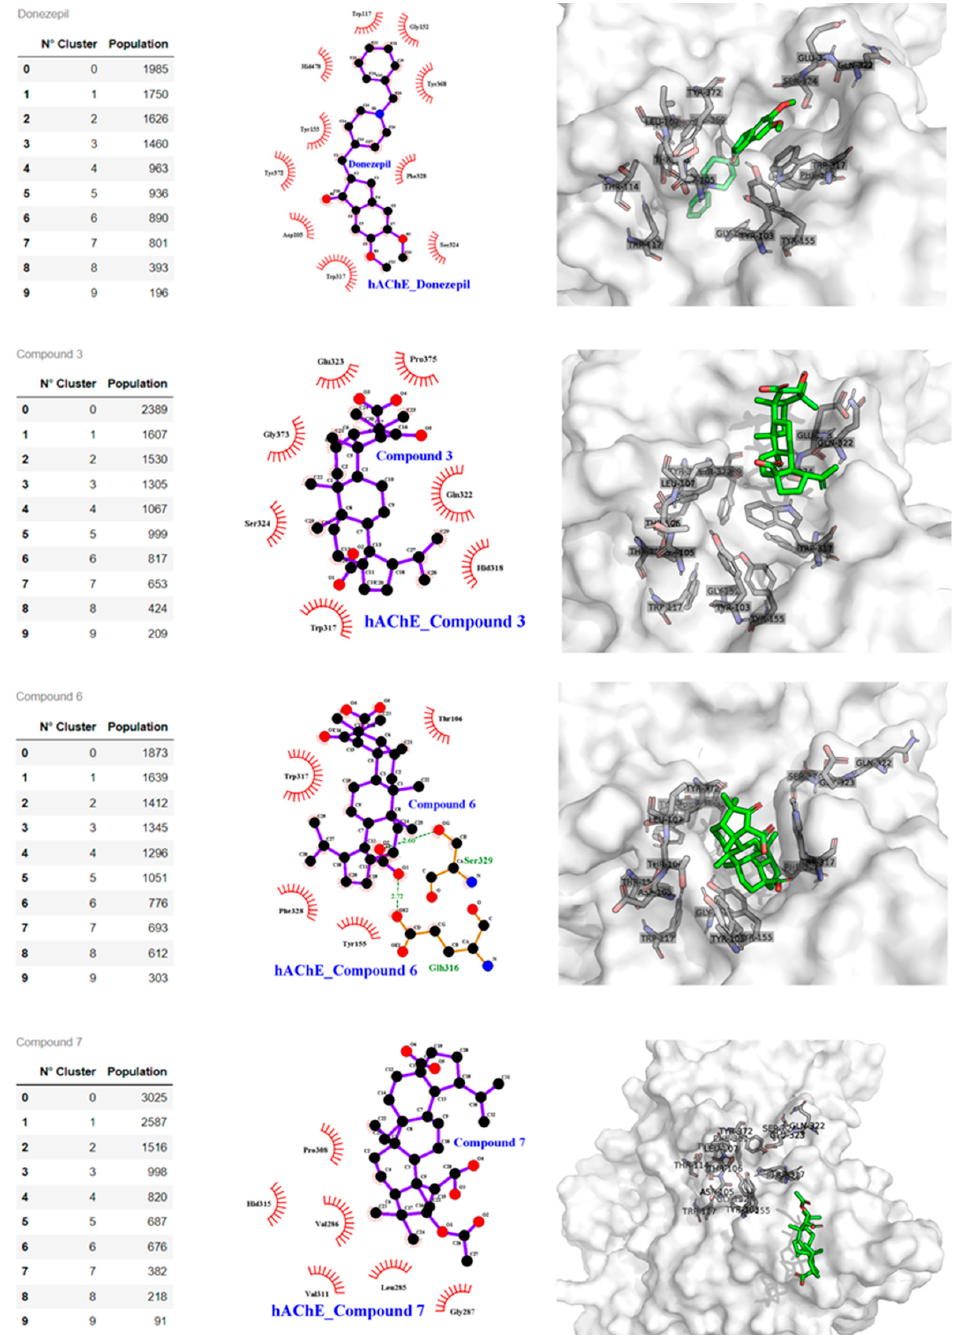
Figure 6. Compound binding cluster analysis from MDS and atomic interactions details. Left panel. Clustering from MDS of the AchE structures and frames population. The centroid of the most populated frame is analyzed with Ligplot and Pymol software. Central panel shows the compound and human AChE interaction at atomic level for Donepezil, compounds 3 , 6 , and 7 . Right panel: 3-D compounds and human AchE interaction; the PAS pocket residues are shown with sticks and labels, the surface is white and transparent, the compounds are with green sticks, and oxygen atoms are in red.